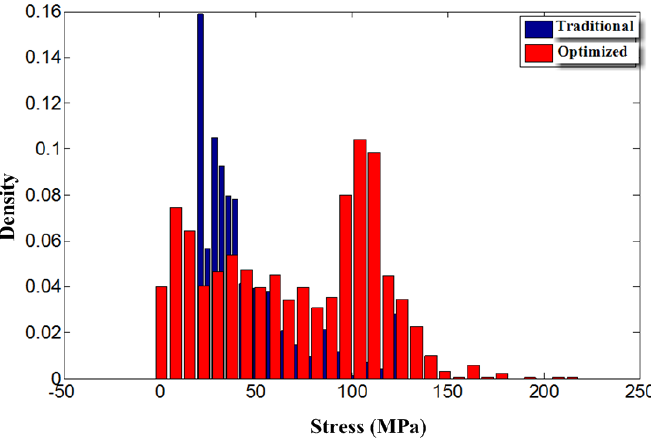
Figure 15. Stress distribution density of traditional and optimized rings.